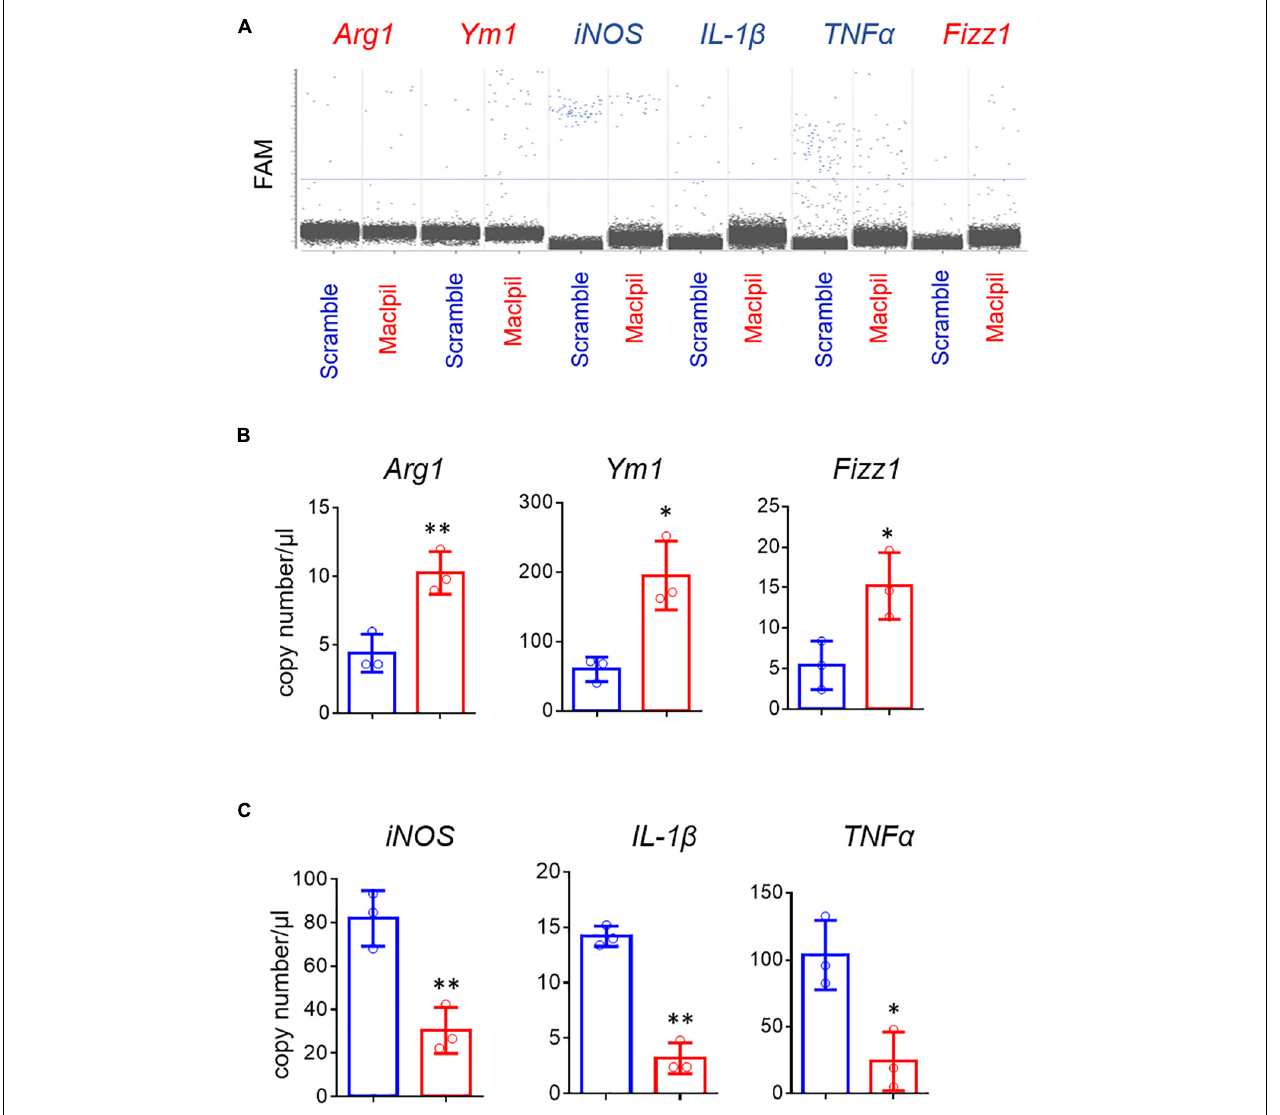
FIGURE 6 | siRNA silencing Maclpil promotes anti-inflammatory gene expression in macrophages undergoing oxygen glucose deprivation treatment. Following oxygen glucose deprivation treatment, total RNA was extracted from marrow-derived macrophages (BMDCs) and subjected to reverse transcript and digital PCR amplification sequentially. (A) Representative 2-D fluorescence amplitude (FAM) plots acquired via digital PCR for individual genes in each treatment group. (B,C) Quantification of anti-inflammatory (Arg1, Fizz1, Ym1) gene (B) and pro-inflammatory (iNOS, IL-1 β and TNF α ) gene (C) expression in BMDCs from different treatment groups. All data are mean and SD from triplicate experiments. Student’s t -test, ∗ p < 0.05 and ∗∗ p < 0.01 compared to scramble siRNA